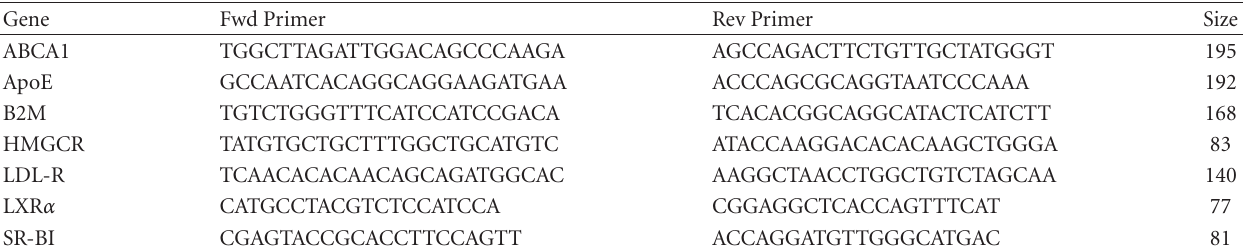
Table 1: QPCR primer